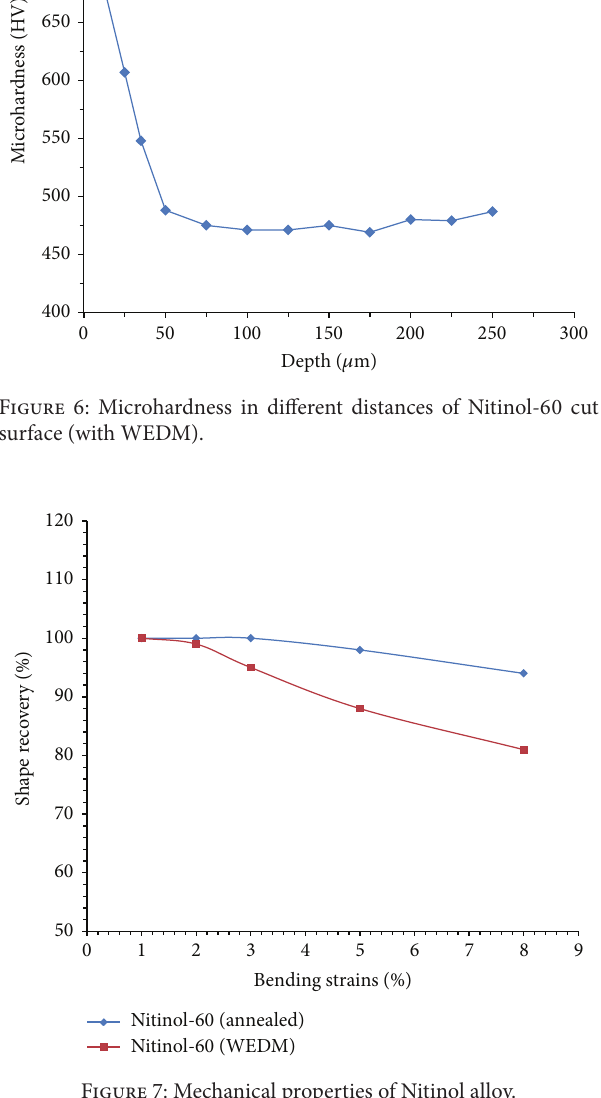
Figure 7: Mechanical properties of Nitinol